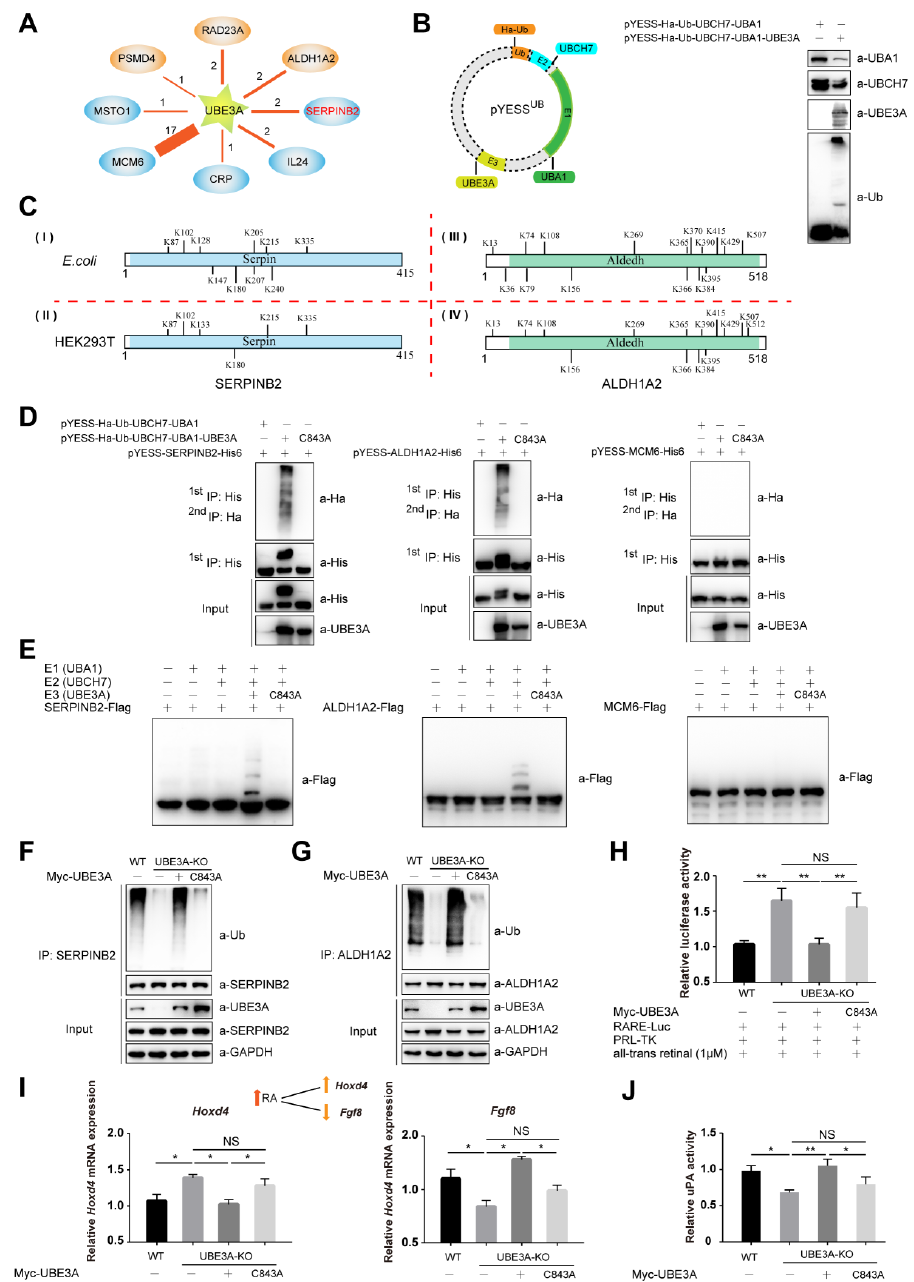
Figure 2. YESS UB , YESS applied to interrogate UBE3A-mediated Ub signaling. ( A ) UBE3A-interacting proteins screened by Y2H with human UBE3A as the bait. ( B ) Reconstituting the E. coli ubiquitination system by transforming YESS UB vector that expressing Ub(Ha-Ub), E1(UBA1), E2(UBCH7) and E3(UBE3A) into BL21 cells and the expression of these proteins was detected by immunoblotting assay. ( C ) A schematic illustration of the ubiquitination sites of SERPINB2 ( Ⅰ and Ⅱ ) or ALDH1A2 ( Ⅲ and Ⅳ ) identified in E. coli (upper panel) or mammalian HEK293T cells (lower panel), as revealed by mass spectrum analysis. ( D and E ) Substrates validation. UBE3A-interacting SERPINB2, ALDH1A2 and MCM6 were individually subjected to ubiquitination assay in E. coli ( D ) or in vitro ( E ) and MCM6 was negative in both tests. +, transfected with indicated plasmid; − , without transfected with indicated plasmid. ( F ) Detection the ubiquitination of SERPINB2 in wild